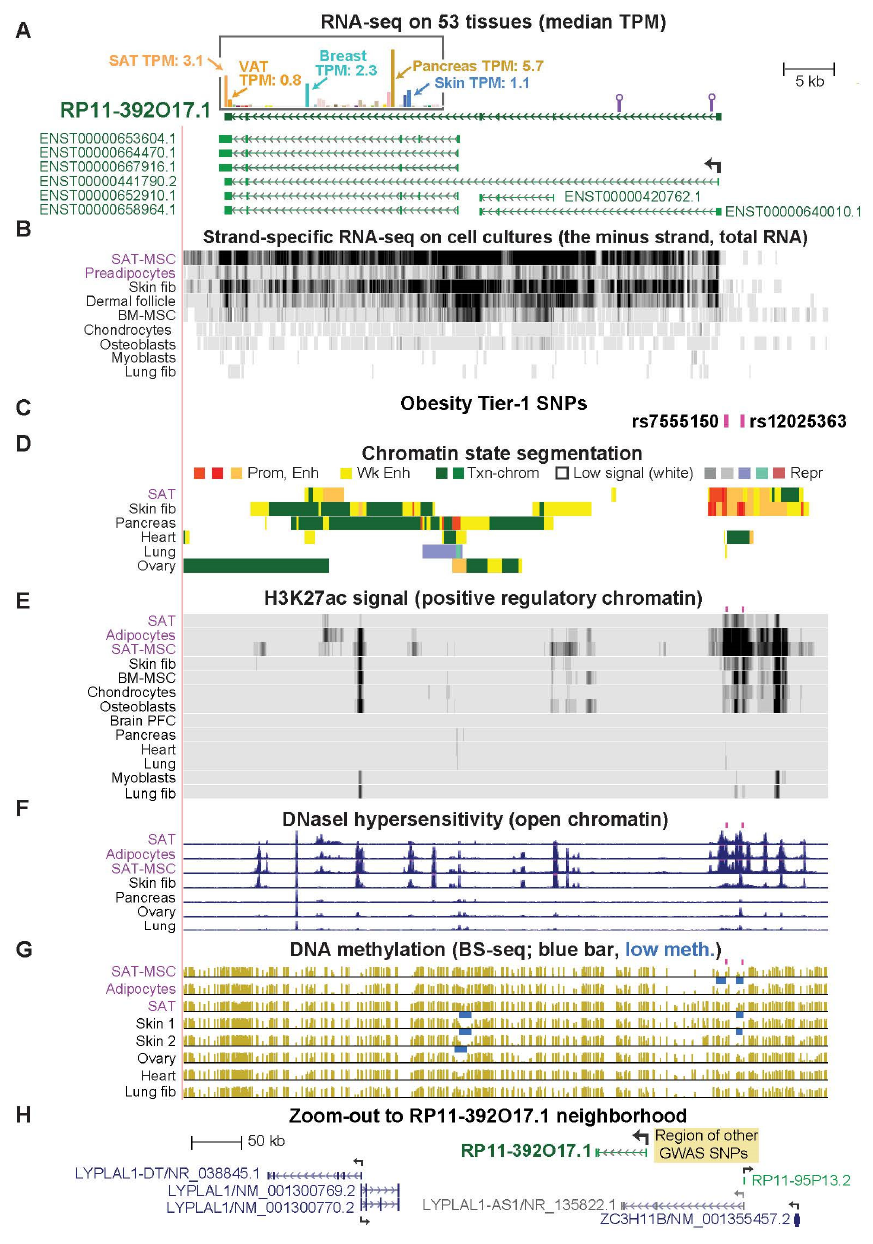
Figure 4. A lncRNA gene, RP11-392O17.1 , associated with SAT-related and female obesity that is often overlooked in assignments of genes to obesity GWAS SNPs. ( A ) A 65-kb region (chr1:219,578,827–219,643,464) containing RP11-392O17.1 ; above it is the tissue RNA-seq profile (GTEx, determined from poly (A) + RNA) for the gene structure depicted immediately underneath it. The RP11-392O17.1 isoforms shown are from the latest Ensembl Comprehensive Gene Annotation Set (v104), but this gene is not yet in the RefSeq database. Purple lollipops, regions that we amplified by RT-PCR as described in the text. ( B ) Cell culture RNA-seq (showing the minus strand) on total RNA, vertical viewing range 0–50. ( C ) The location of two Tier-1 SNPs. ( D – G ) Chromatin state segmentation, H3K27ac, DHS, and bisulfite-seq, as in the previous figures. There were no CpG islands in the region shown. TPM, transcripts per million; VAT, visceral adipose tissue; SAT-MSC, subcutaneous adipose tissue-derived mesenchymal stem cells; BM-MSC, bone marrow-derived MSC; fib, fibroblasts; BS-seq, whole genome bisulfite sequencing; meth, methylation. ( H ) Annotated genes in the 0.6-Mb region (chr1:219,183,979–219,829,670) that contains RP11-392O17.1. The LYPLAL1-AS1 /NR_135822.1 gene is shown in gray because of the lack of RNA-seq support for this gene structure. Tan rectangle, the region 11–118 kb upstream of RP11-392O17.1 that was cited in many studies as having obesity GWAS SNPs associated with LYPLAL1 (Supplementary Figures S9 and